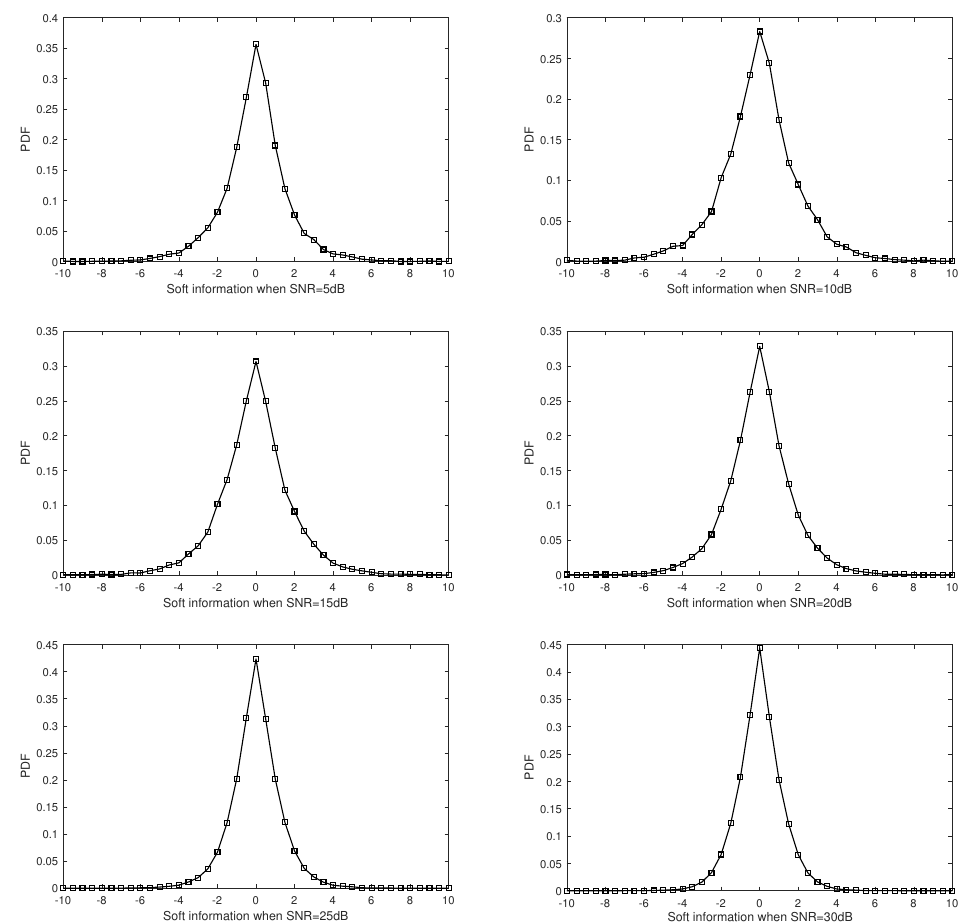
Figure 5. Probability density function of wrong soft